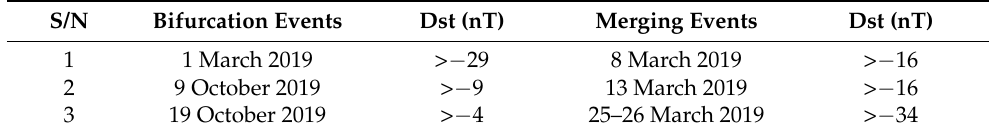
Table 1. Dates of events studied.